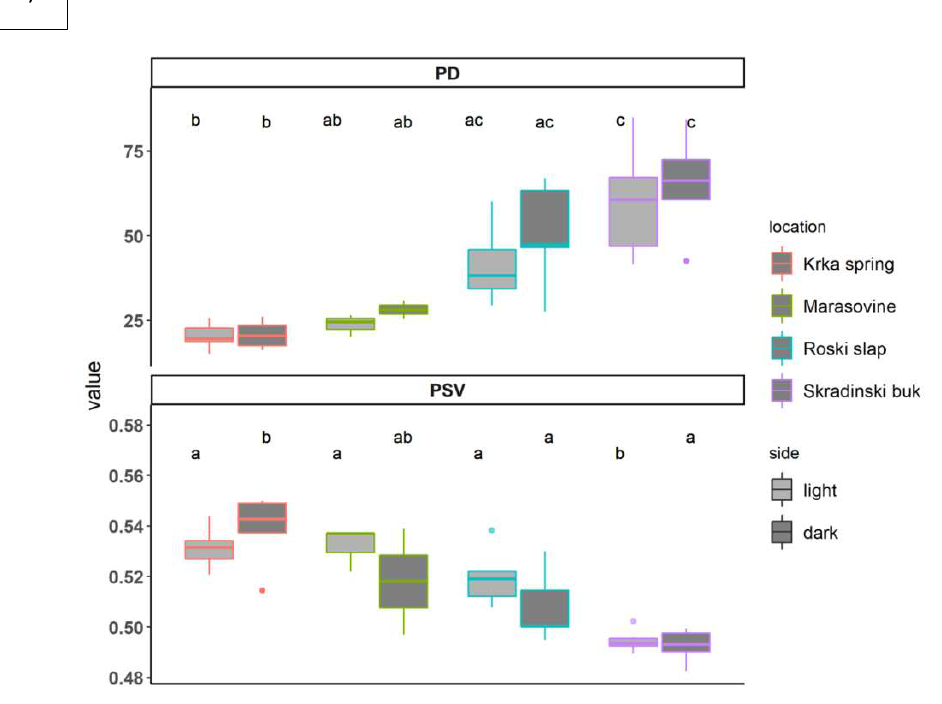
Figure 2. Changes in phylogenetic alpha diversity indices for PD—phylogenetic diversity and phy- logenetic species variability index—PSV ( a ) and functional richness—FRic ( b ) visualised by box- plots for each sampling side and location; the horizontal thick black band represents the median values, and the boxplot margins indicate first and third quartiles, different letters above boxplots indicate significant differences among sampling side and location based on Tukey’s HSD test. The lighter grey colour denotes light-exposed samples, whilst darker grey colour denotes dark-exposed